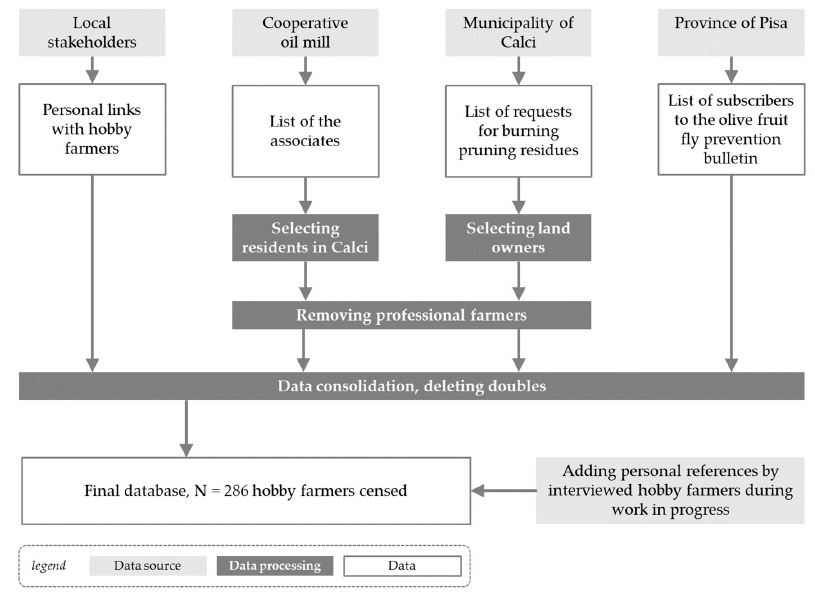
Figure 3. Hobby farmers census method.